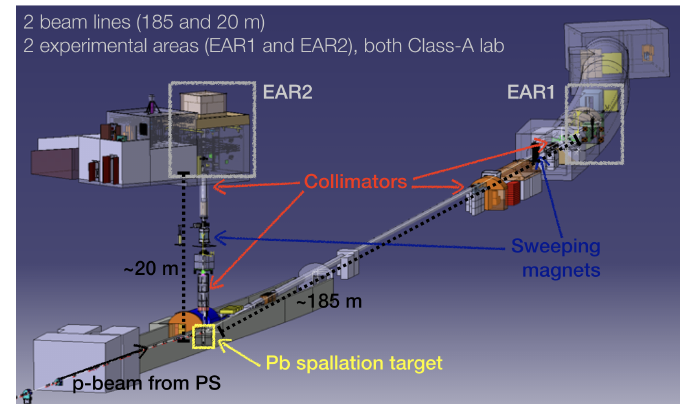
Figure 1. Scheme of the n_TOF facility. The main component of the neutron source and the two neutron beam-lines are